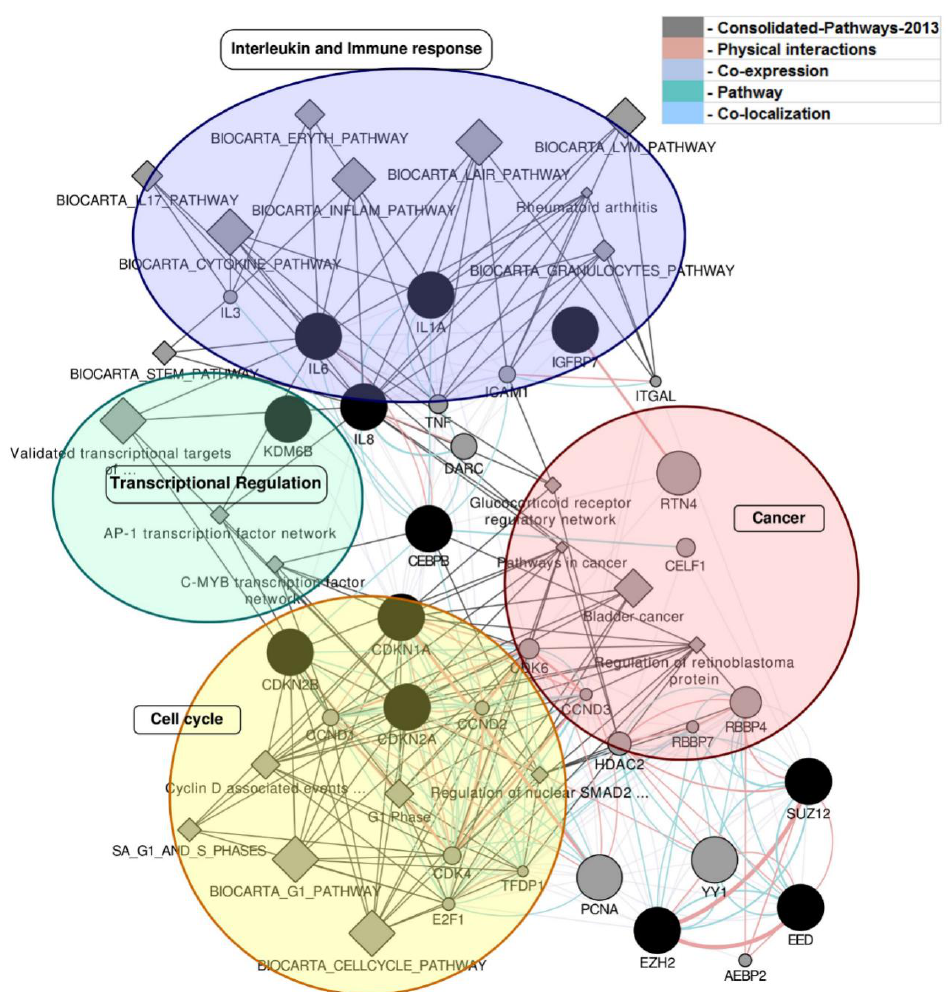
Figure 2. miRNA targeted network of cancer signaling including senescence. Signaling networks of different pathways identified from the analysis of over expressed miRNAs in GBM and their associated targets represented in this network. Black filled circles represent the miRNA input target genes identified from our enrichment analysis and target mapping. Filled Gray circles represent associated genes, having the closest functional relationships with input target genes. Gray diamond shaped nodes represent sub-networks or pathways, having a functional relationship with the genes of interest. Connecting edges are drawn based on the evidence from consolidated pathway databases, physical interactions, co- expression profile, pathways, and co-localization profiles. A network also showing clusters of four different signaling pathways, as highlighted; the top light purple ellipse shows that the most nodes and connections are linked to interleukin and immune response. The small circle on the left, highlighted with light green, shows transcriptional regulation related entries. The light red circle on the right most interestingly shows cancer-linked pathways in genes. The bottom yellow circle shows signaling pathways, which are very essential to cell cycle regulation. Four senescence-linked pathways are present, containing at least 14 genes, as listed in Table 2. Pathway information are selected, based onReactomePathway Database entries, mapping to the identified miRNA target from the